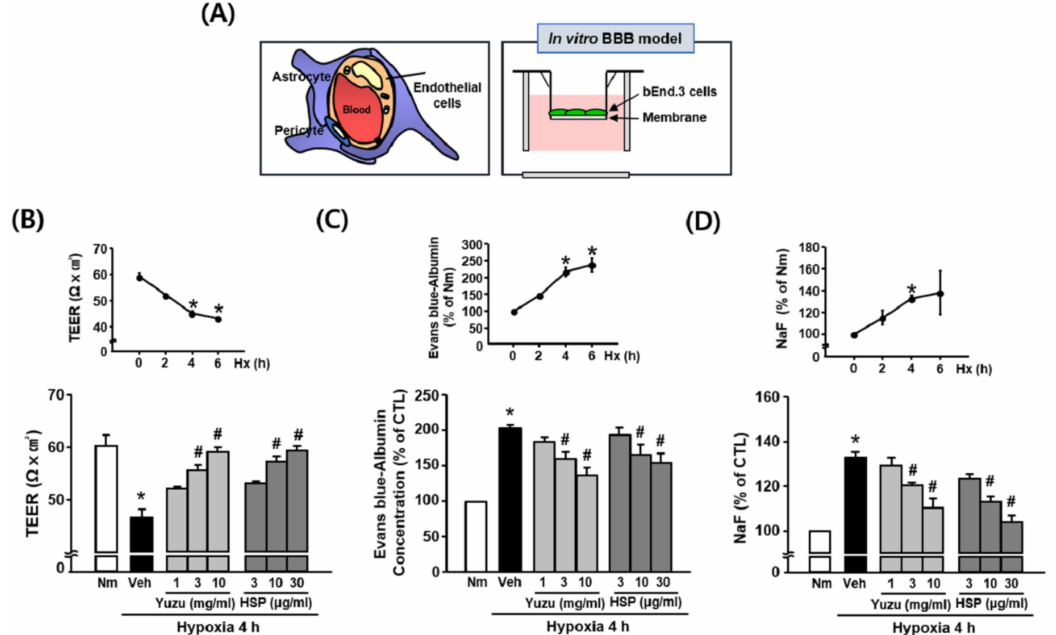
Figure 2. E ff ects of yuzu and hSP on BBB permeability during hypoxia in bEnd.3 cells. ( A ) Schematic representation of in vitro model of BBB. ( B – D ) ( B ) TEER (trans-endothelial electrical resistance), ( C ) Evans blue–albumin concentration, and ( D ) NaF were measured at normoxia and at 2, 4, and 6 h of hypoxia. Data are shown as mean ± SEM ( n = 5–7). Quantitative analysis of ( B ) TEER, ( C ) Evans blue–albumin concentration, and ( D ) NaF in the brain endothelial cell monolayer was measured 4 h after hypoxia. Data are shown as mean ± SEM ( n = 5–7). All experiments were pretreated with